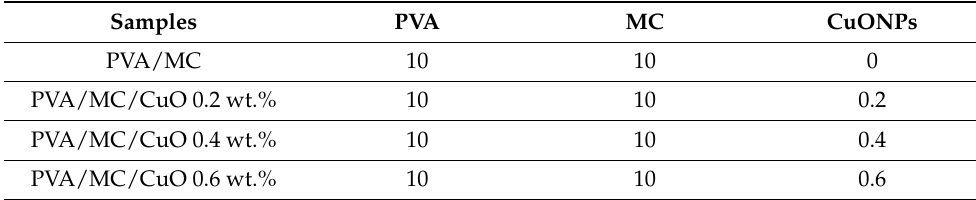
Table 1. Sample codes with concentrations of PVA, MC, and